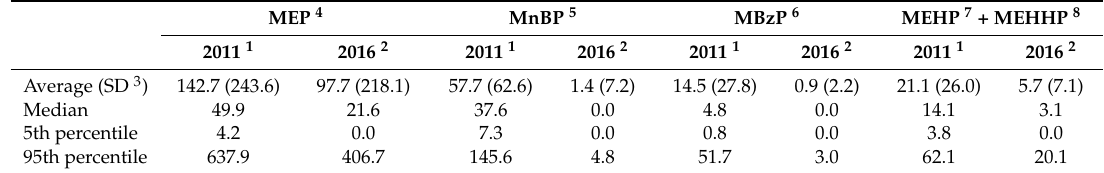
Table 6. Results of urine analysis of men ( µ g/g